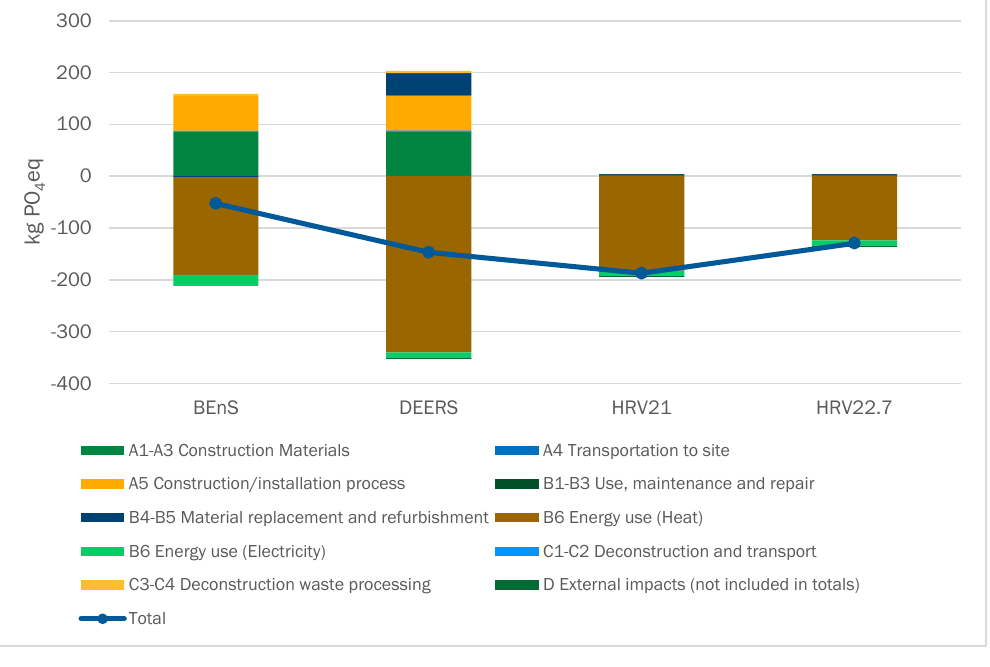
Figure 4. Eutrophication potential (PO 4 eq).